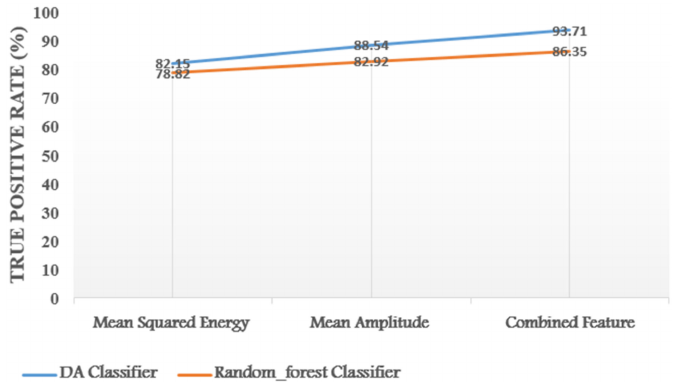
Figure 10. Effect of Feature kind on TPR values for different